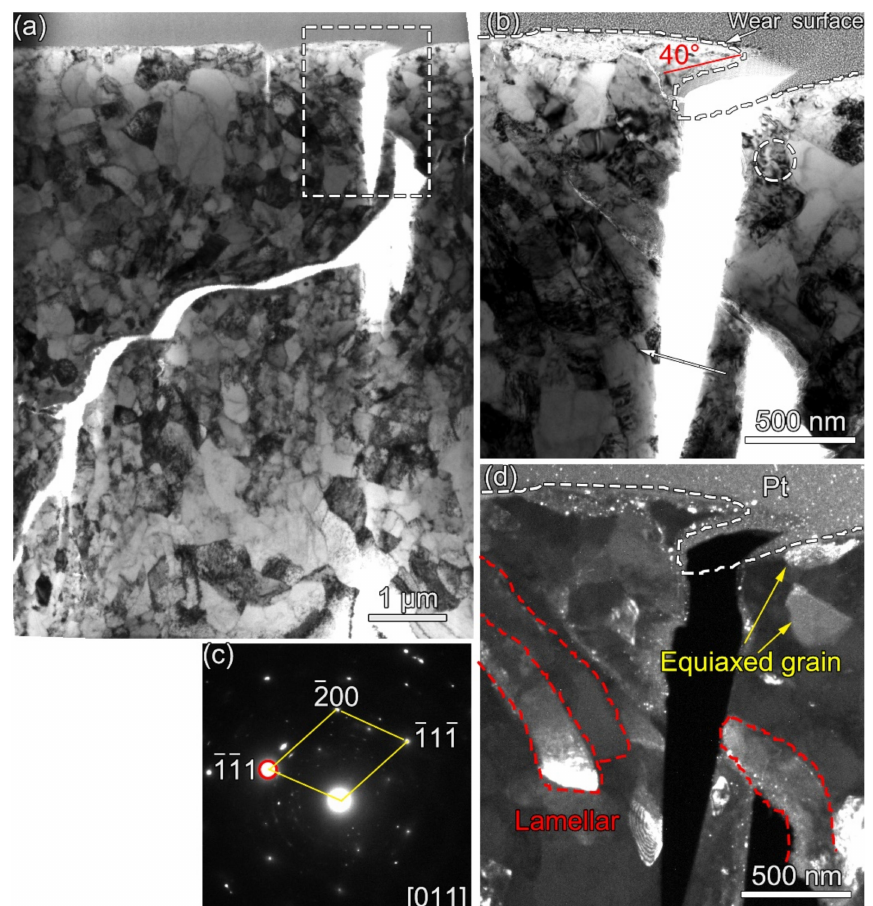
Figure 10. ( a ) An overview cross-sectional BFTEM image of the wear scar at the 1200th cycle after the final polishing of the FIB process. ( b ) The magnified image from the rectangle in ( a ). ( c ) The indexed SAED taken from the dashed circle in ( b ). ( d ) The corresponding DFTEM image taken from the red site in ( c